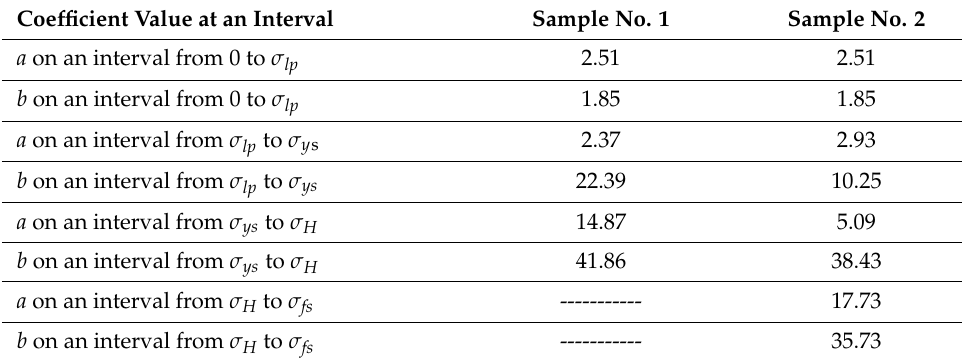
Table 4. Values of the shape parameter and scale factor for printed 60Al 2 O 3 /40PLA samples 1 and 2